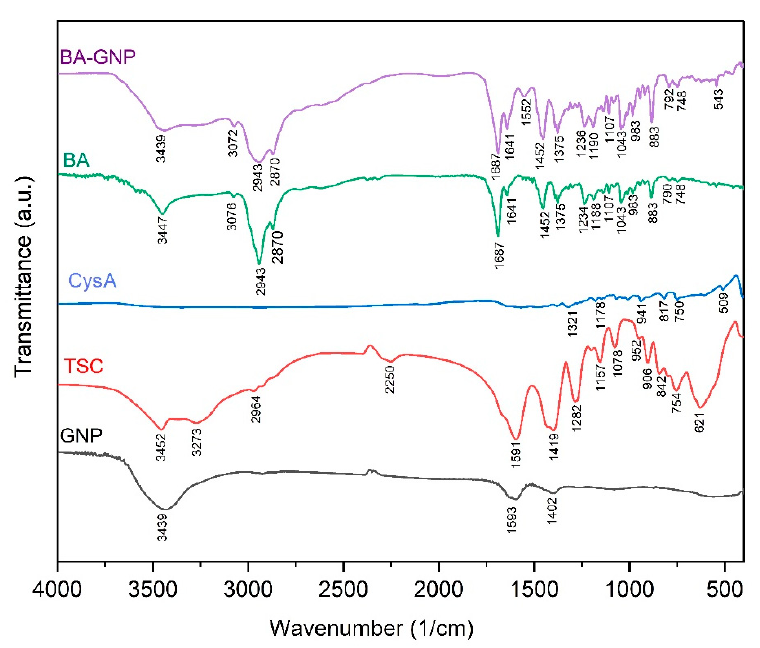
Figure 3. FTIR spectra of BA-GNP, BA, cysteamine (CysA), trisodium citrate (TSC) and citrate-GNP.